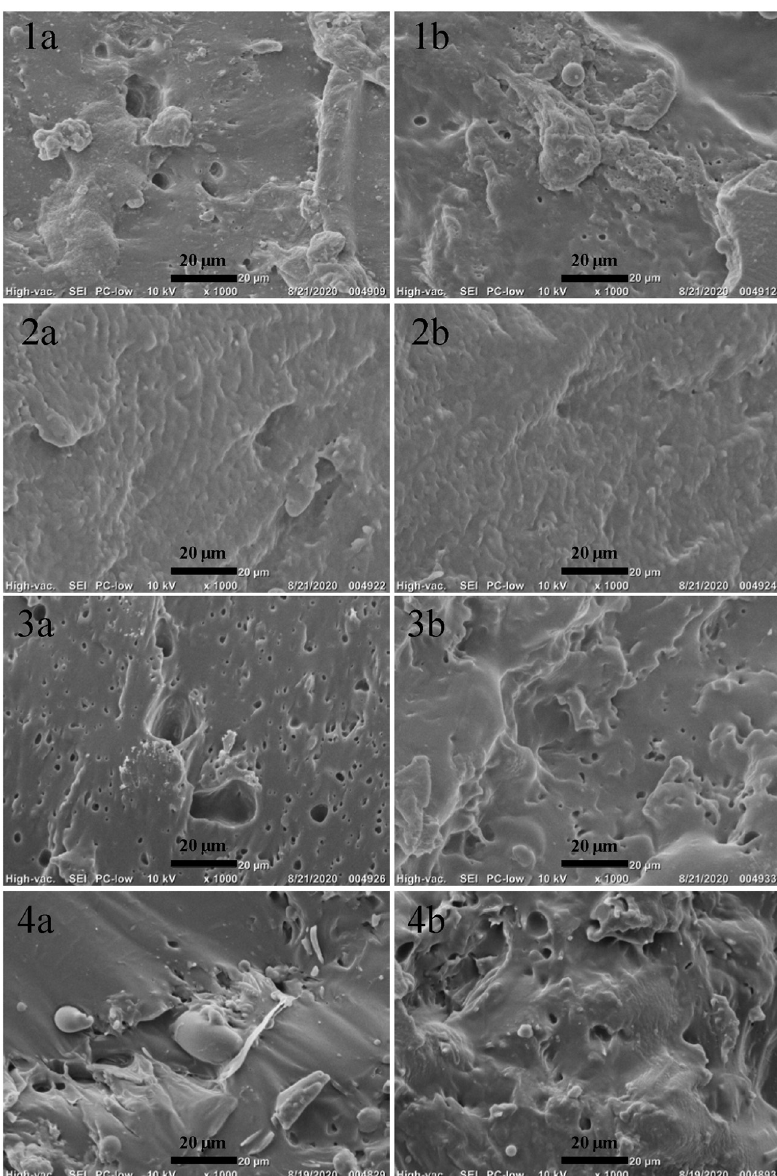
Figure 2: SEM images of the cross - section of PVA/PLA blend specimens: ( 1 ) PVA0588/PLA = 30/70, ( 2 ) PVA0588/PLA = 50/50, ( 3 ) PVA1788/ PLA = 30/70, ( 4 ) PVA1788/PLA = 50/50, ( 1a – 4a ) the cross - section of the sample without compatibilizer, ( 1b – 4b ) the cross - section of the sample with